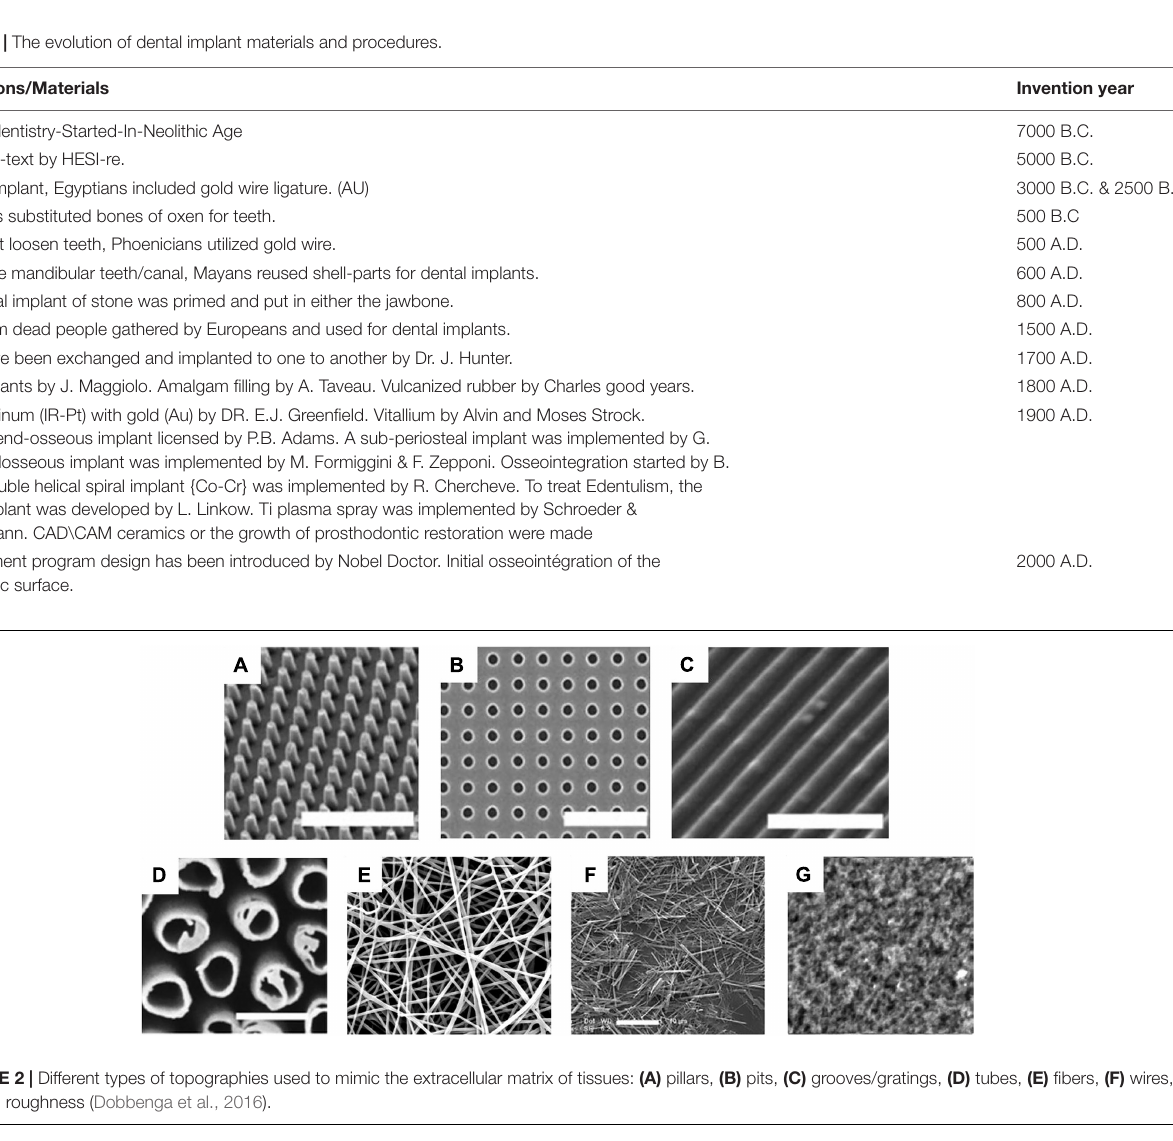
superimpose a high density of nanostructure onto Ti